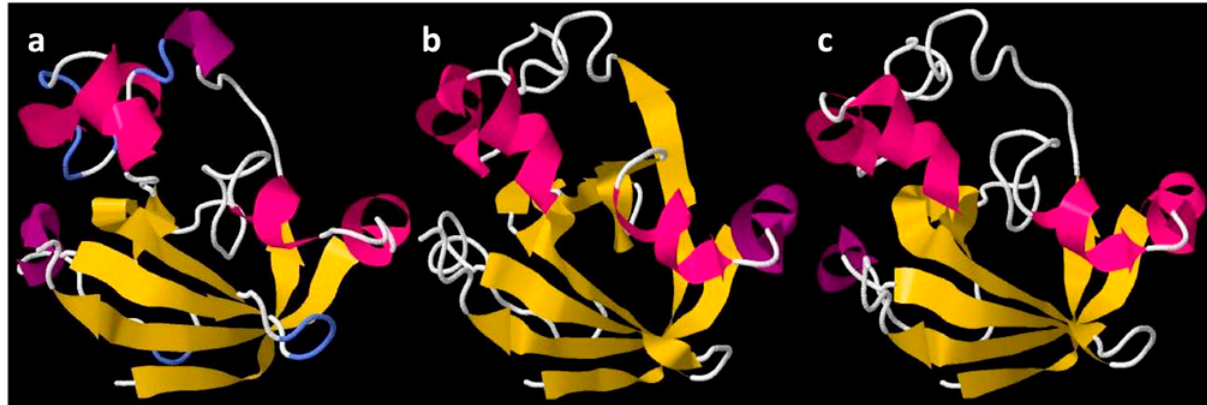
Figure 4. Three dimensional structural model of the a. deduced LcPR4a, b. Barwin (PDB 1bw3) and c. Wheatwin1 (PDB 1C2Z) proteins. The structure of LcPR4a was predicted through homology modelling using Barwin as template.